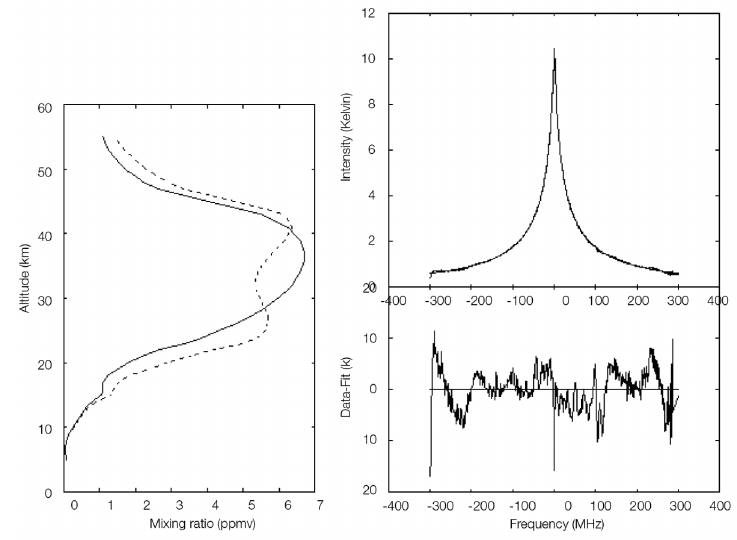
Fig. 1. ( Top, right ) Measured spectral line data after subtraction of computed background from other nearby ozone transitions. A line shape synthesized from the retrieved vertical profile (solid line, left panel) is superimposed on the observed spectrum, but can be barely distinguished. The difference spectrum between these is shown on an enlarged scale ( bottom, right ). Spectral intensity is given in kelvins for the equivalent emission temperature in the Rayleigh-Jeans approximation. The dashed line in the left hand panel is one of three starting profiles used for de- convolution of each day’s data. The solid line is the profile retrieved from the data in the upper right